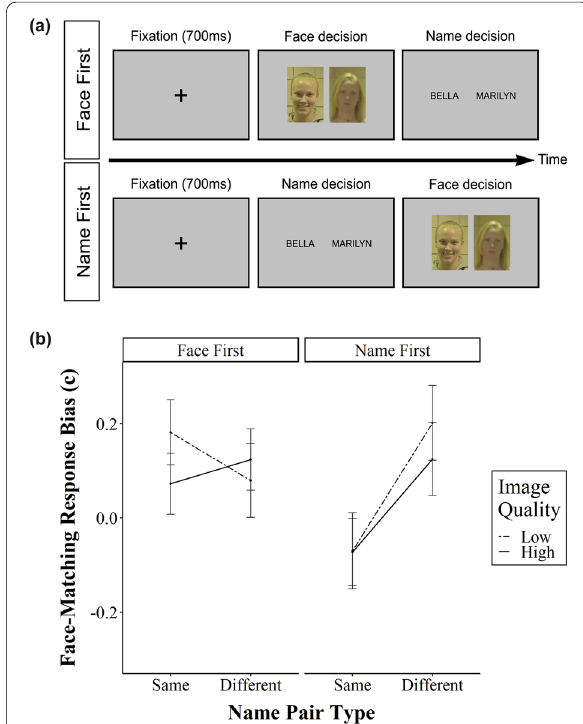
Fig. 2 a An example of a trial sequence in Experiment 1. In the name-first condition (bottom), a fixation cross is presented, followed by a name-matching decision and a face-matching decision. In the face-first condition (top), the name decision and face decision in the trial sequence occur in the reverse order. Both trial sequences show